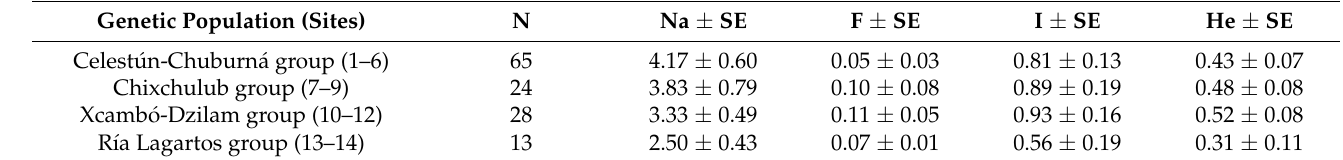
Table 2. Genetic diversity ± standard error in four genetic populations of C. yucatanicus identified in the northern Yucatan Peninsula, Mexico. Sample size (N), allele richness (Na), Inbreeding Index (F), Shannon diversity index (I), expected heterozygosity (He), and standard error (SE). N Na ± SE F ± SE I ±